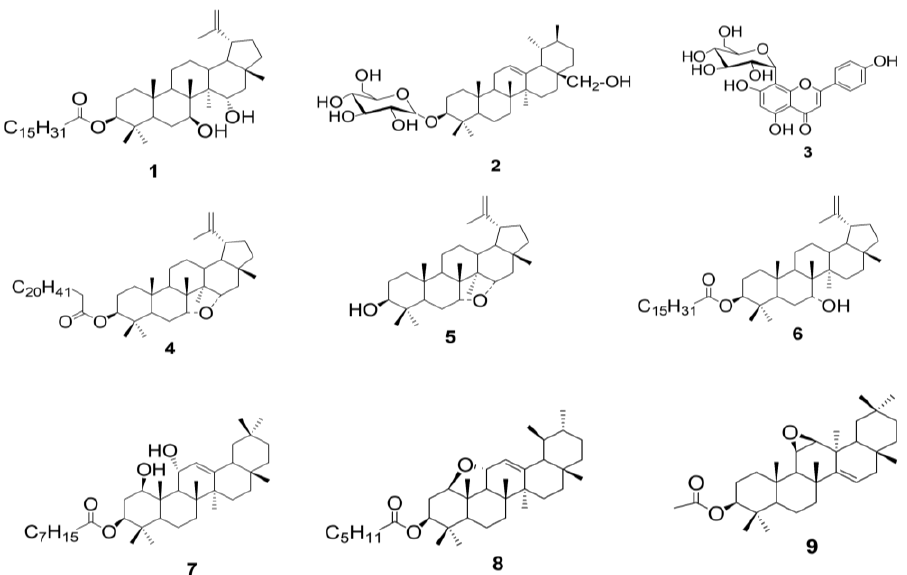
Figure 1. Chemical structures of isolated compounds: 7 β ,15 α -dihydroxy- 3 β -palmitatelup-20(29)- ene ( 1 ), 3-O- β -D-glucopyranosyl-28-hydroxy- α -amyrin ( 2 ) and apigenin- 8-C- β -D-glucopyranoside ( 3 ) were isolated from the leaf extract of P. capitata . Globimetulins A ( 4 ), B ( 5 ) and C ( 6 ) were